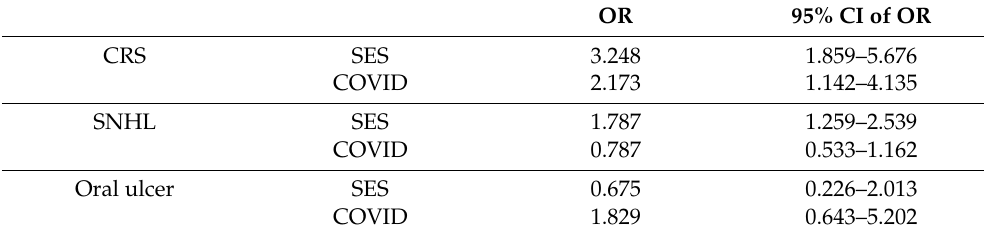
Table 3. The impact of socioeconomic status on disease severity before and during COVID-19. OR 95% CI of OR CRS SES 3.248 1.859–5.676 COVID 2.173 1.142–4.135 SNHL SES